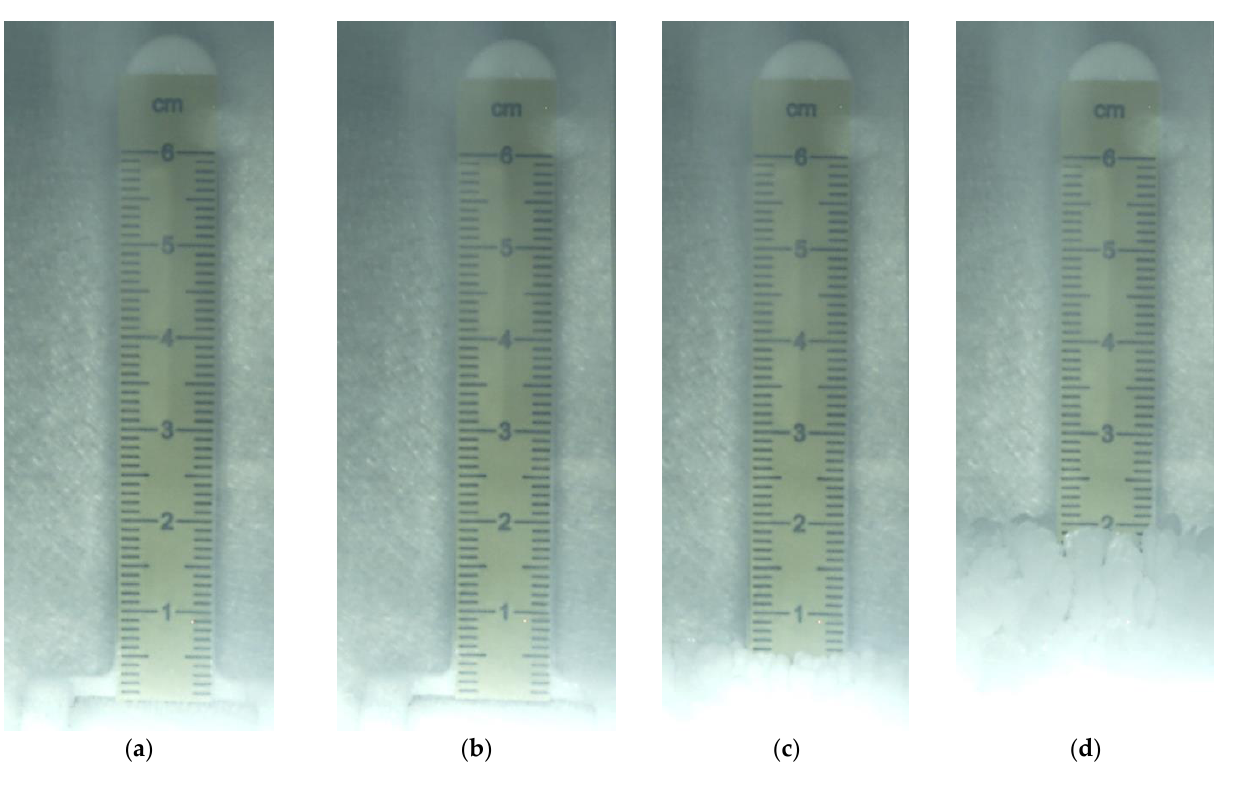
Figure 19. Ice ruler occupation with ongoing freeze drying duration: ( a ) experiment start, ( b ) start of primary drying, ( c ) further primary drying, and ( d ) end of primary drying.